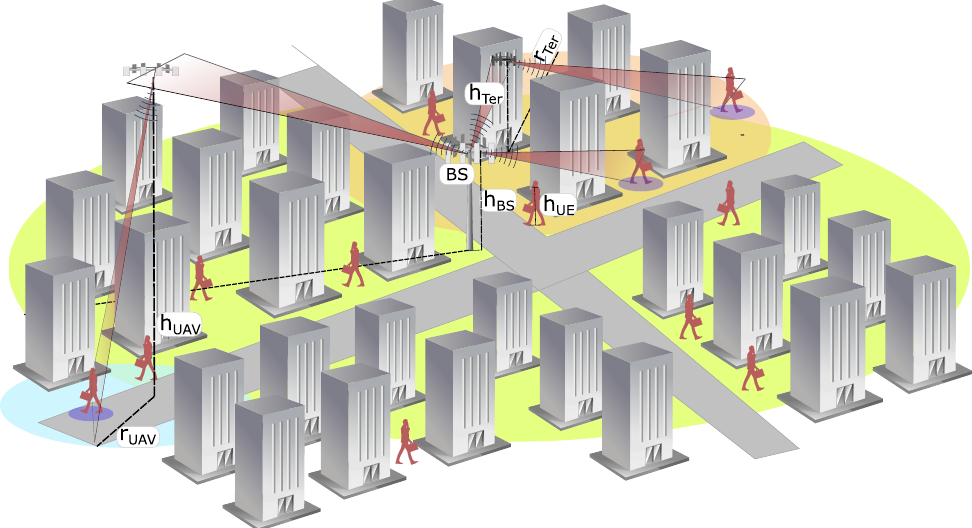
Figure 1. The considered deployment